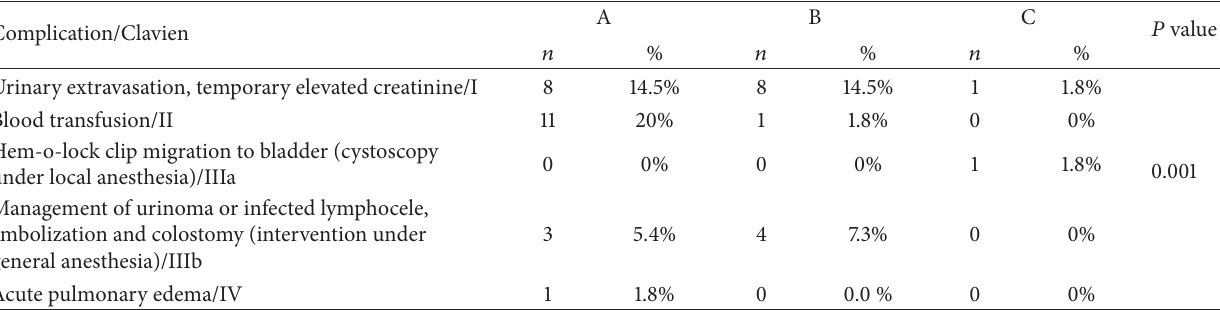
Table 1: Postoperative complications (Clavien-Dindo classification).